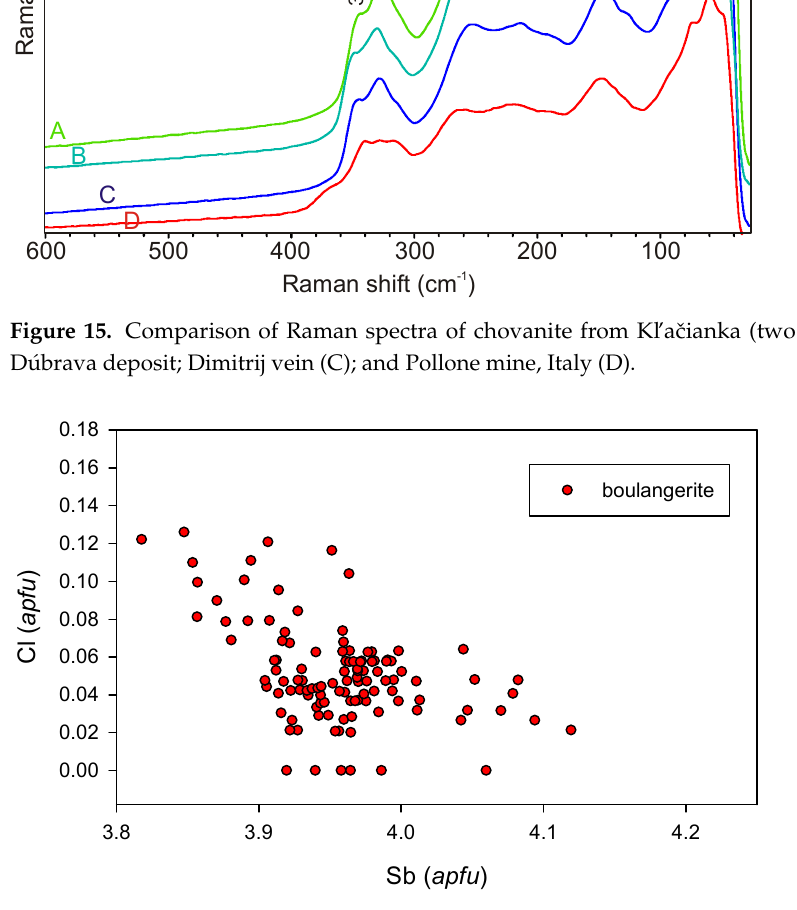
Figure 16. The graph of Sb vs. Cl contents ( apfu ) for